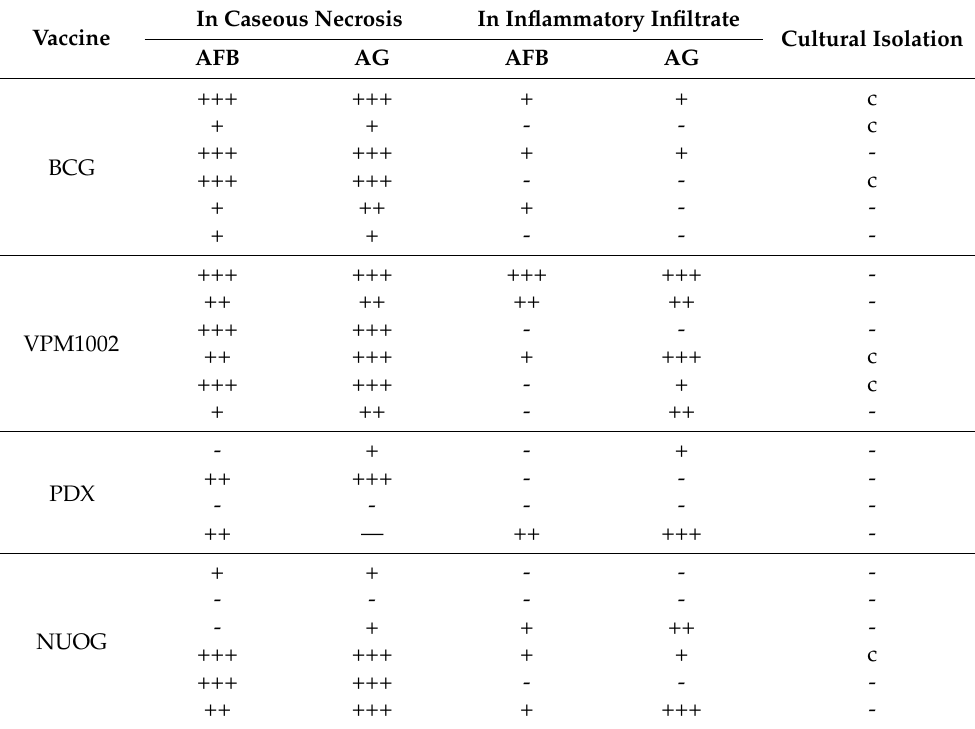
Cultural Isolation